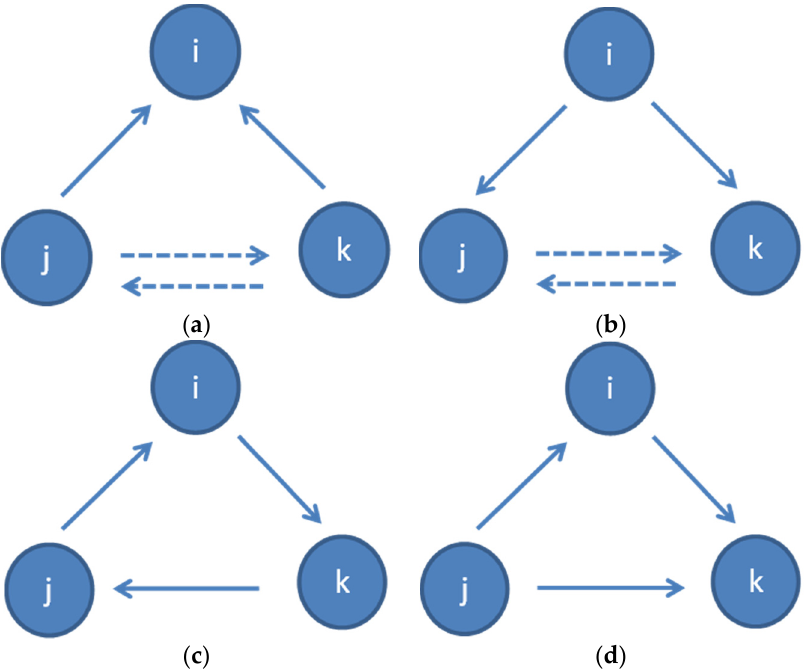
Figure 4. Possible triangles in directed clustering coefficient analysis: ( a ) In, ( b ) Out, ( c ) Cycle, ( d ) Middleman.